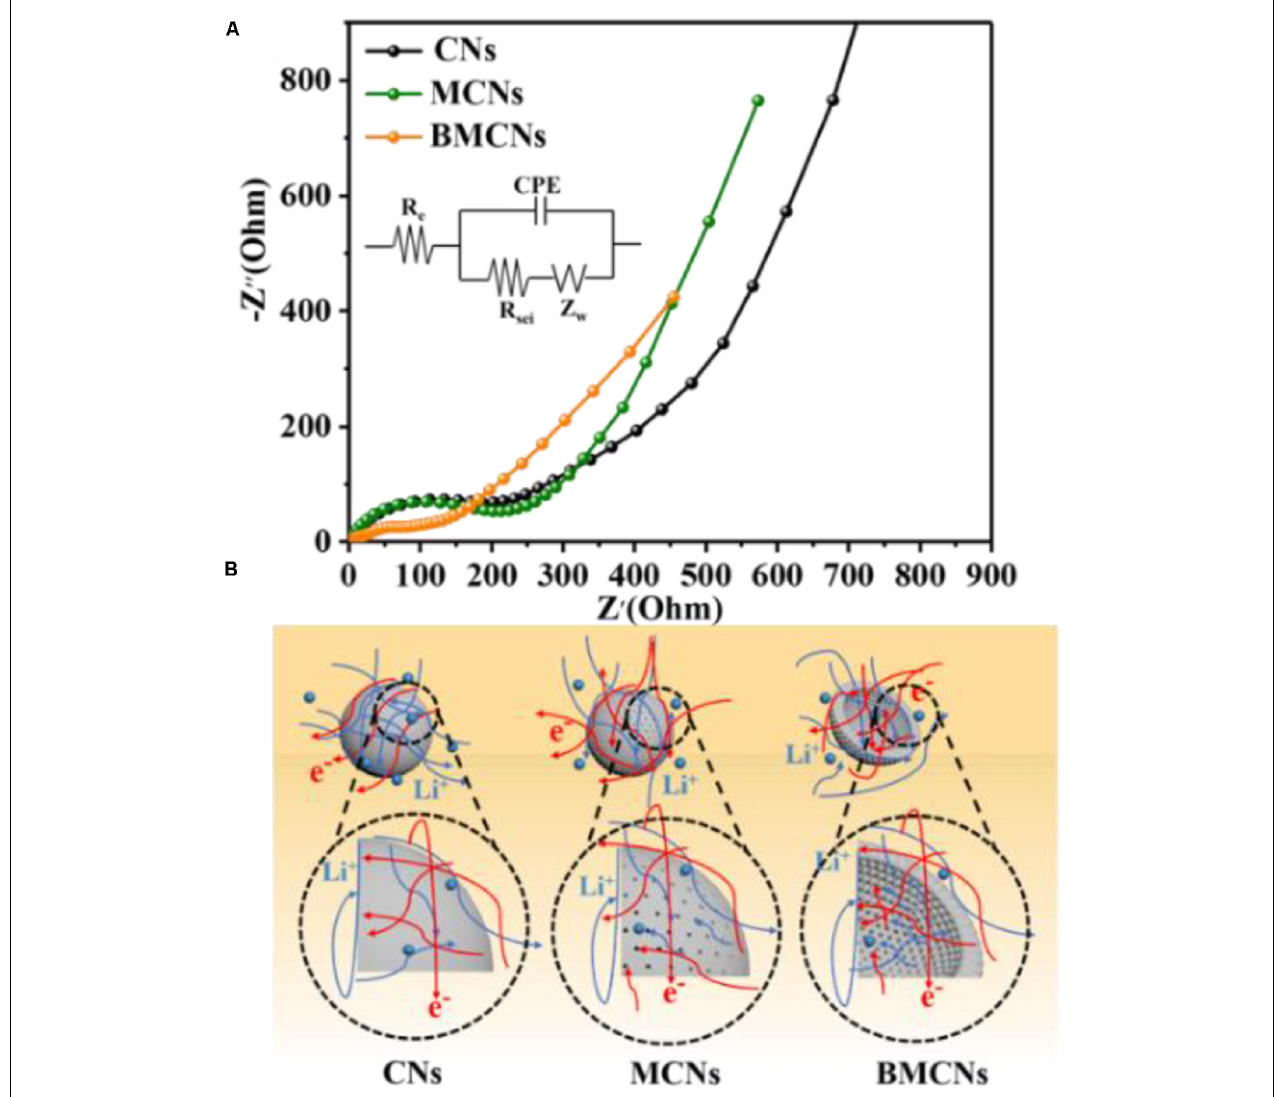
FIGURE 4 | (A) Electrochemical impedance spectra and equivalent circuit (inset) of the CN, MCN, and BMCN electrodes obtained after 50 cycles at 2 A g − 1 . (B) Schematic illustration for the lithium-ion and electron transport in the CN, MCN, and BMCN electrodes.